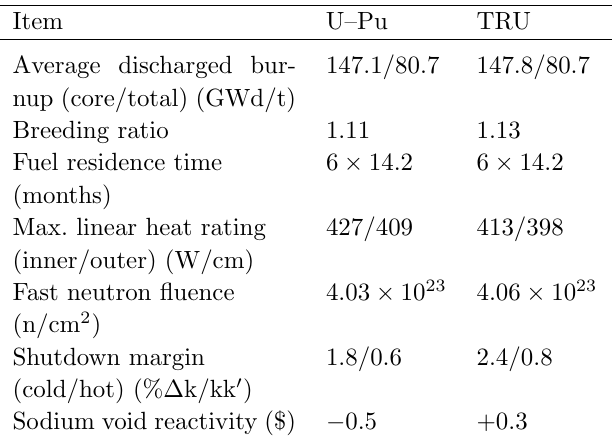
Table 4. Main performances of enhanced high burnup CFV